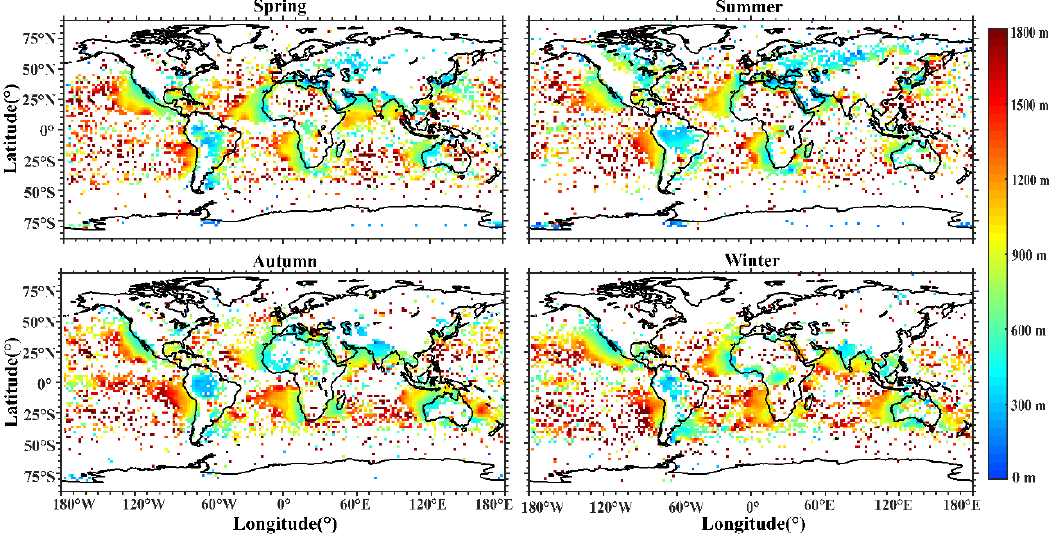
Figure 7. Distribution of the trapping layer altitude with season variations. The blank grids represent that there is no trapping layer event.